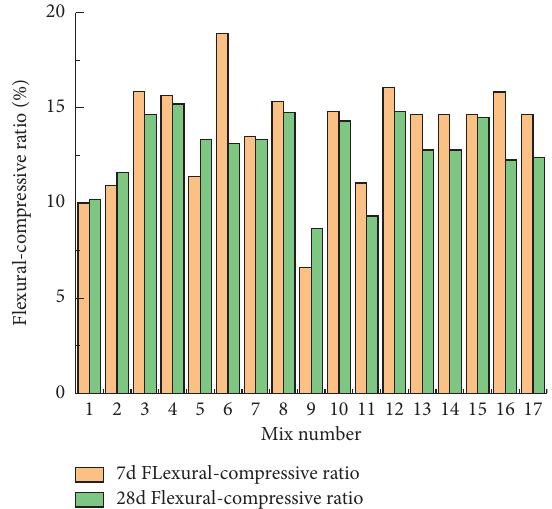
Figure 6: Flexural strength of different mix design and different age.